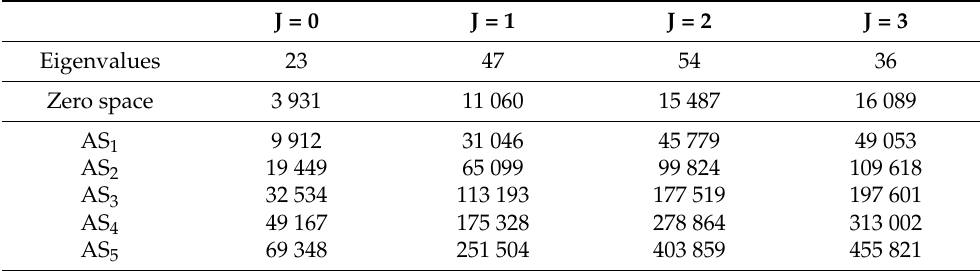
Table 1. MCDHF calculations for the even states of Mg VII. For each J -block, the number of targeted levels (eigenpairs) and sizes (number of CSFs) of the zero-space and CSF-expansions for the different orbital active sets are listed.